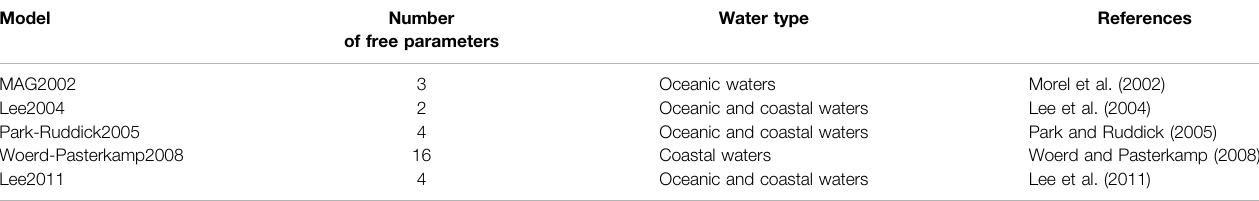
TABLE 1 | Summary of BRDF models used to assess